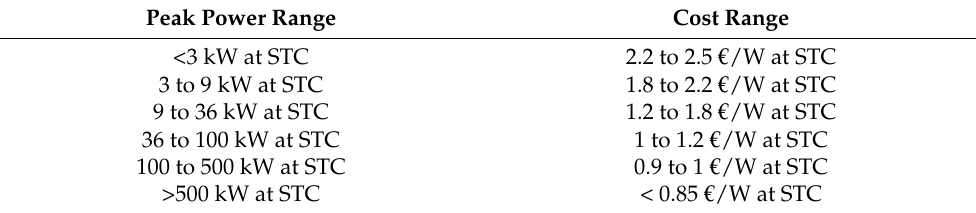
Table 2. Infrastructure costs excluding tax for PV panels installed on the roof of houses/buildings.